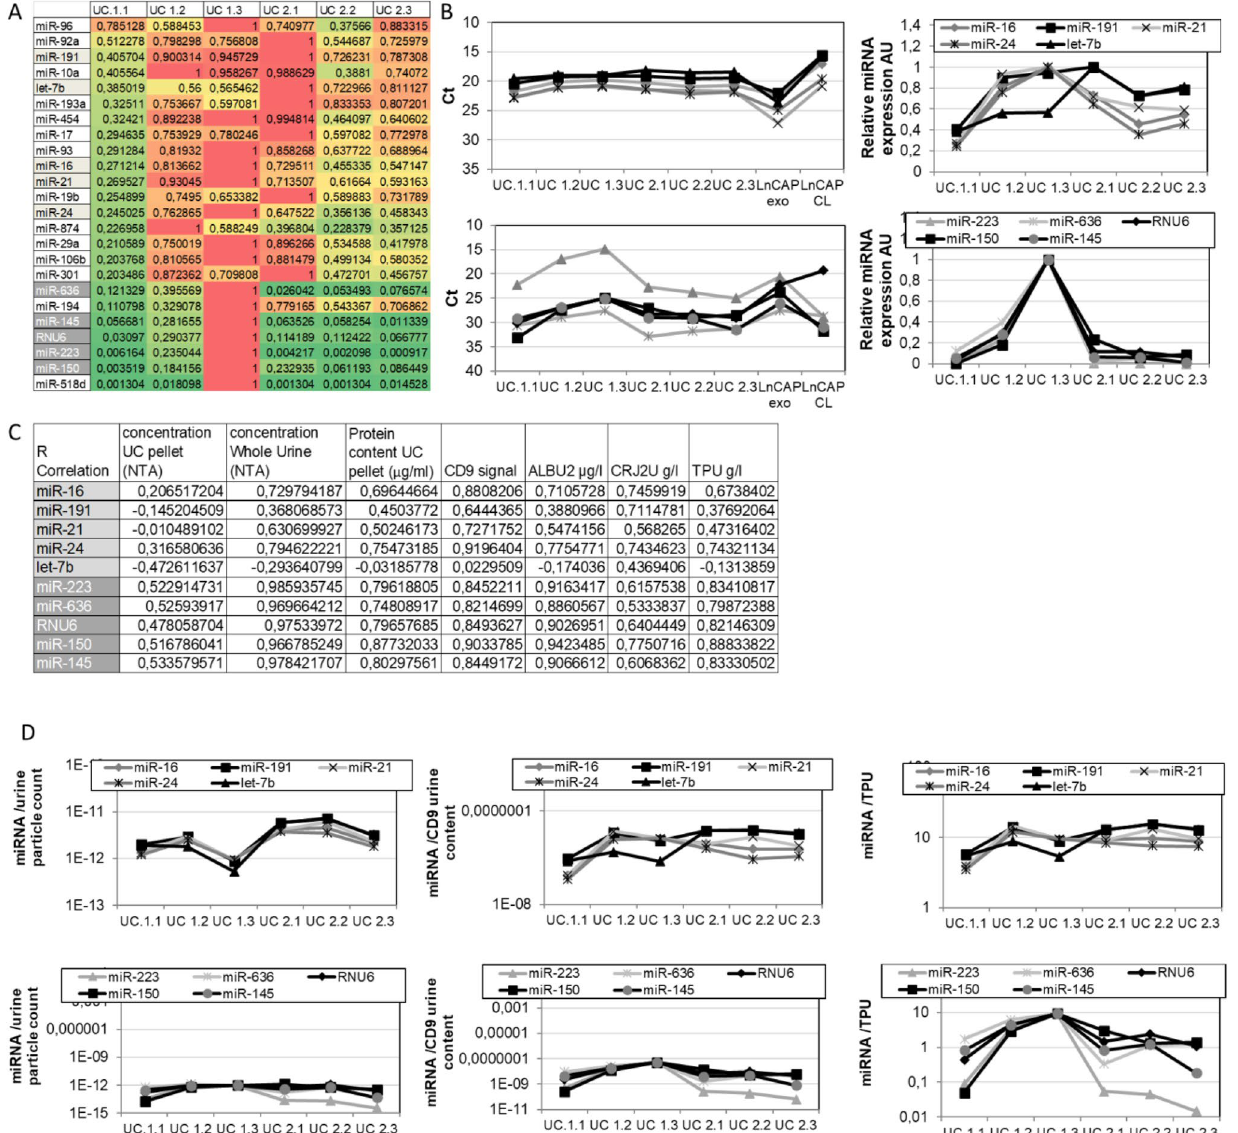
Figure 10. Detection urine of EV-miRNAs by RT-qPCR in longitudinal urine samples. Following ultracentrifugation, total RNA has been extracted from EV and MV pellets and RT-qPCR amplification and quantification of a 24 miRNA Taqman Custom Array performed as described. The results are expressed both as Ct values ( B ) and as relative RNA expression (Table A , and panel B on the right) calculated as delta Ct versus reference sample (RNA extracted from Prostate Cancer LnCAP cell line exosomes). The correlation index was determined between the trend observed for miRNA expression levels across the samples and the respective values for selected EV parameters (particle concentration and protein content) as well as biochemical parameters measured in the same urine samples (creatinine, albumin and total protein content) ( C ). Finally, the normalization of miRNA expression levels at longitudinal points is attempted using best correlating EV and urine parameters ( D ). EVs (UC) were purified by differential (ultra)centrifugation-based protocol from urine obtained from two healthy volunteers, one female (marked as 1) and one male (marked as 2), 45 and 43 years old, in 3 subsequent days. Experimental points are shown on relative x axes. For each sample two aliquots of urine were processed independently and